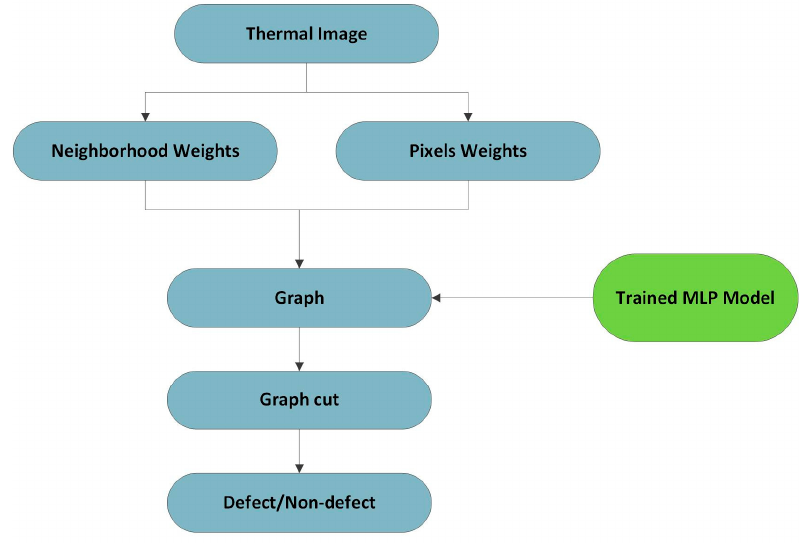
Figure 4. Generic diagram to improve accuracy of the defect/non-defect detections.